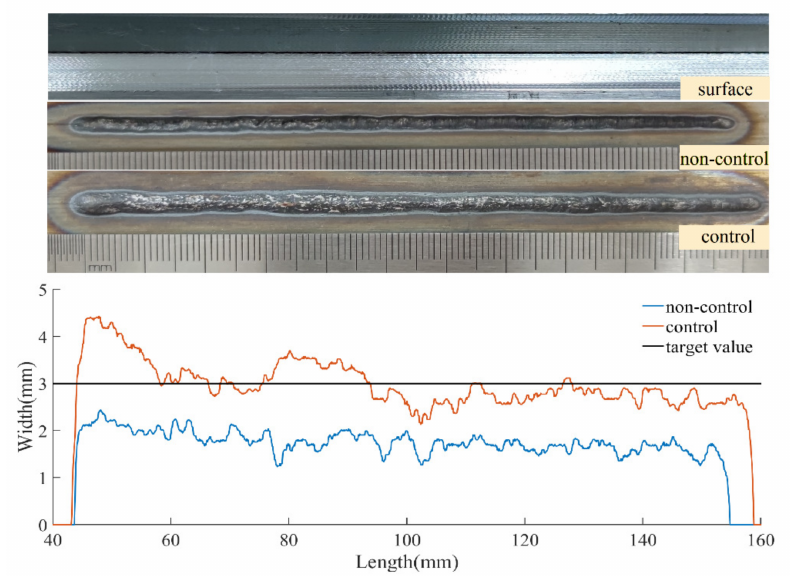
Figure 10. Comparison of results of the bottom molten pool width of butt welding with the groove angle gradually changing from 30 ◦ to 45 ◦